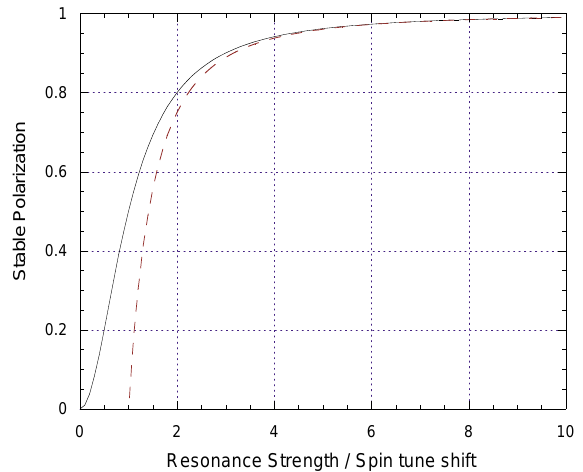
FIG. 1. The average stable polarization magnitude during the spin-flipping process is plotted against the ´ (cid:3) Dn s ratio. The solid curve is derived analytically from the spin transformation over two turns around the ring. The dashed curve is stable polarization predicted by Eq.